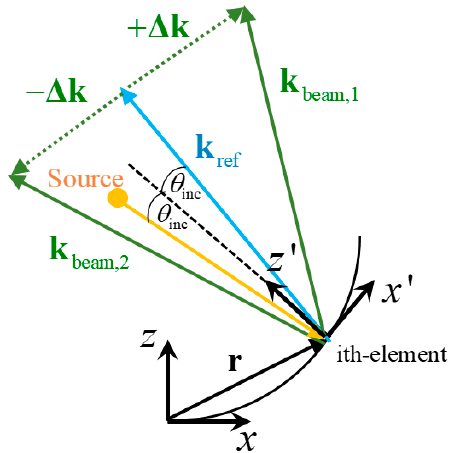
Figure 1. Scheme of a reflectarray on an arbitrary surface reflector. The curved black solid line indicates the arbitrary surface (flat or curved) of the reflectarray. The propagation vectors of the impinging and reflected waves by law of reflection are shown. The propagation vectors of the desired reflected waves are also shown. These last vectors are specular vectors with respect to the direction of the propagation vector k ref .